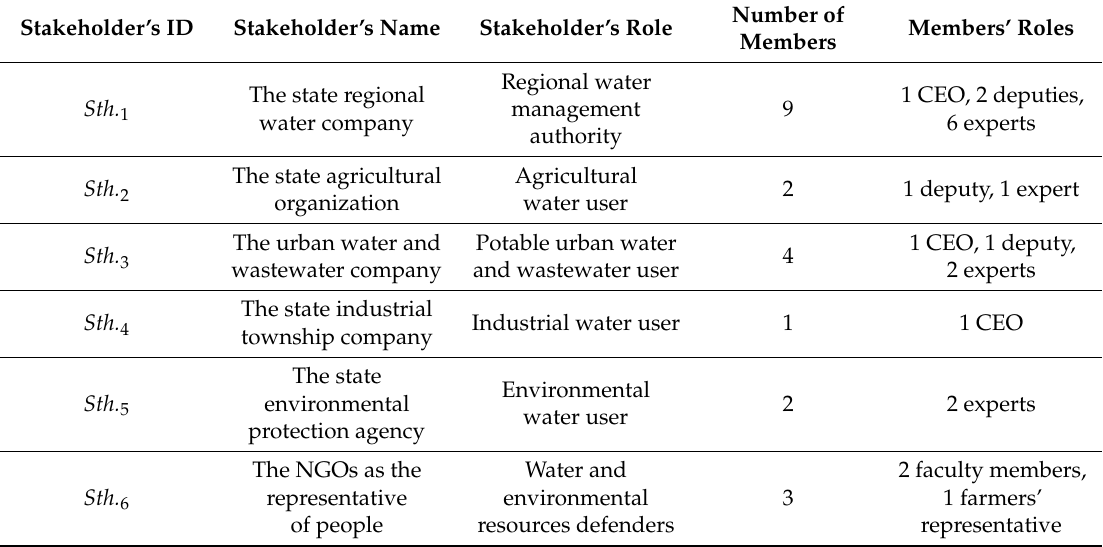
Table 3. List of stakeholders and the relevant members collaborated in the Kashafroud GDSS model. NGOs: non-governmental